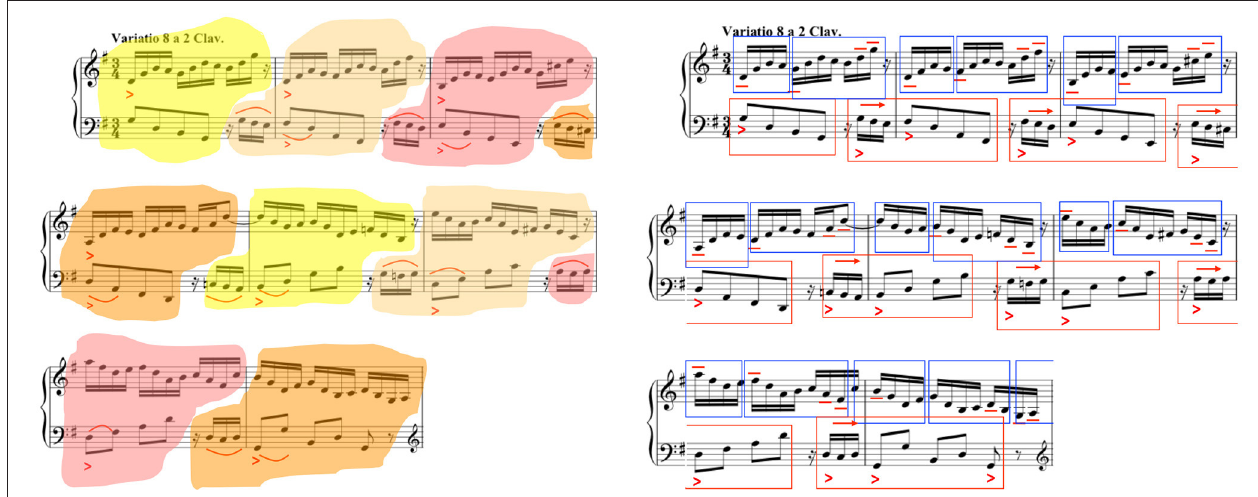
FIGURE 1 | Grouping structures in Glenn Gould’s recordings of Goldberg Variation 8 (left) in 1955—see vimeo.com/159472151—and (right) in 1981—see vimeo.com/159488217. Reproduced from Chew